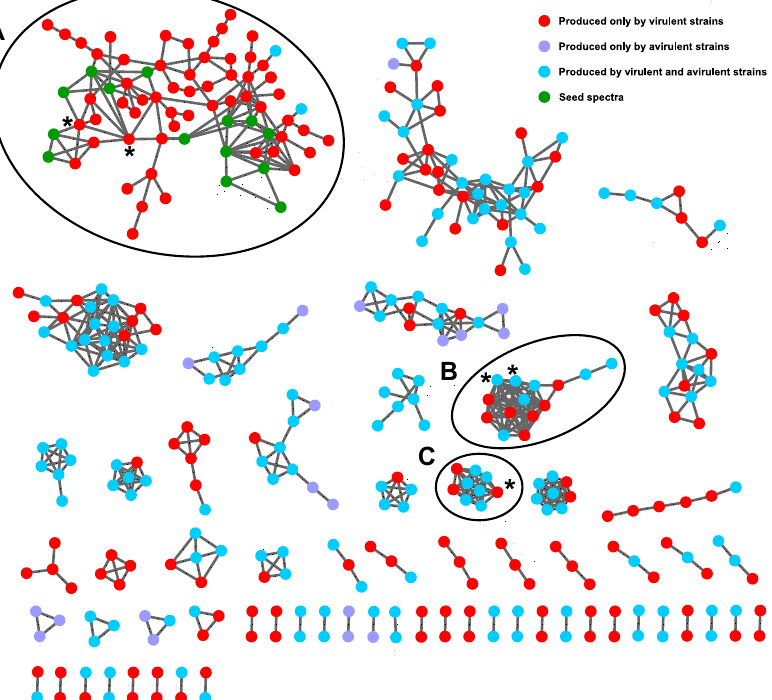
Figure 2. GNPS molecular network of metabolites from strains of Ilyonectria and Neonectria grown on potato dextrose agar. Nodes represent features detected by tandem HRMS (positive ionization mode), and lines represent cosine similarity scores above 0.6. The five most abundant compounds produced by virulent strains are found within clusters A, B, and C, and are indicated by (*).